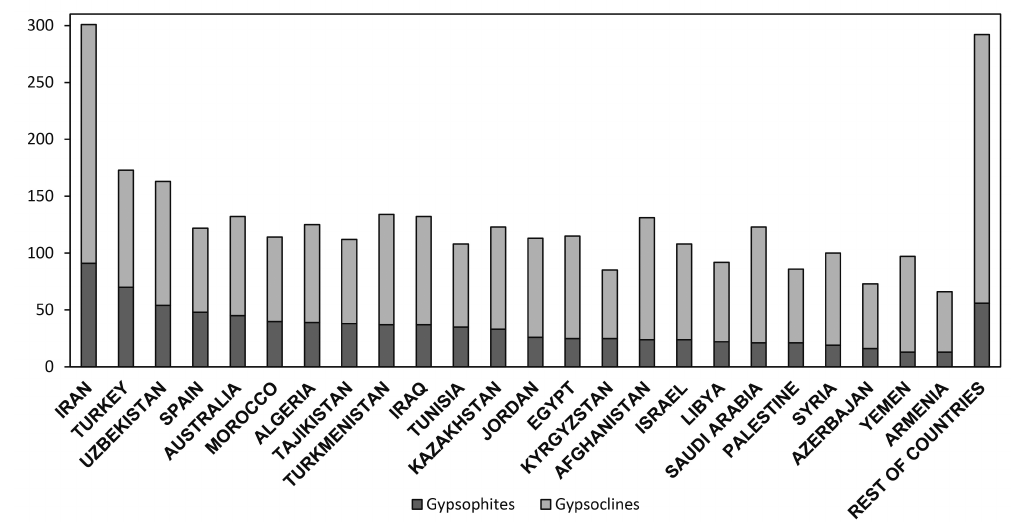
Figure 4. Distribution of taxa by